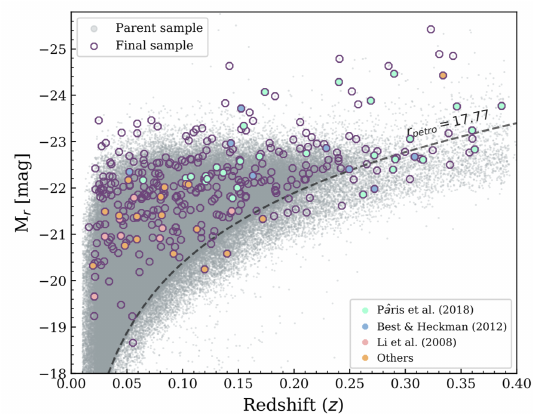
Figure 1. Absolute extinction-corrected r-band magnitude as a function of redshift. Grey dots and purple circles show our parent sample and final sample; the sources identified as AGN in some other works are also shown (Section 2.3). The dashed curve shows the SDSS Petrosian r-band magnitude corresponding of r petro = 17.77